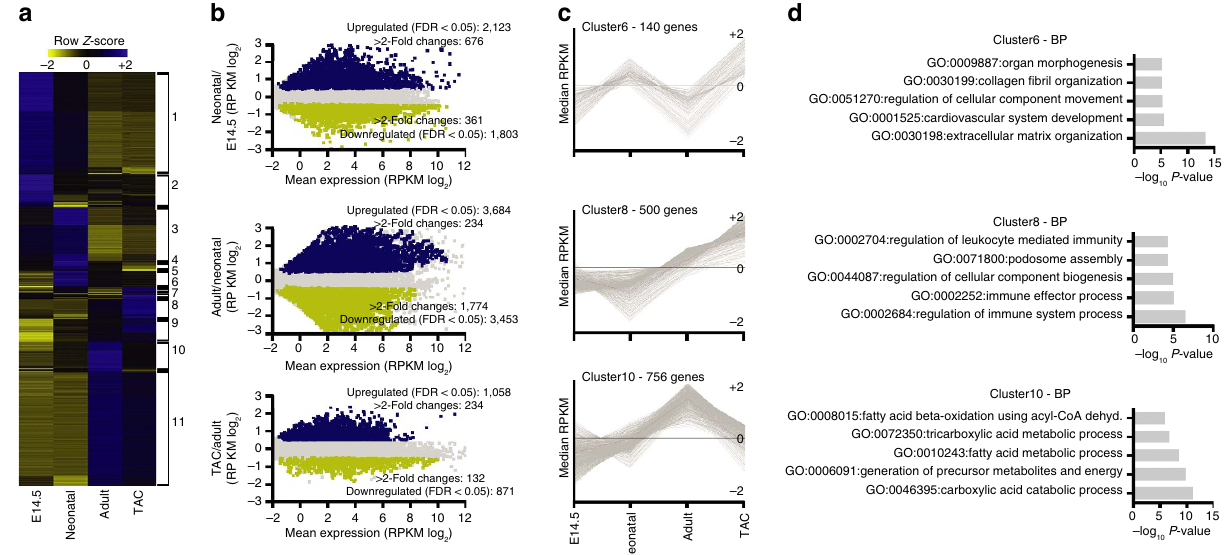
Figure 2 | Transcriptional analysis during development and hypertrophy. ( a ) Hierarchical clustering of the 10,302 transcripts expressed differentially among embryonic, neonatal, normal adult and hypertrophic CMCs (adjusted P -value r 0.05, Benjamini–Hochberg correction for multiple-testing). SOTA cluster numbers are indicated to the right. ( b ) Comparison of gene expression in the developmental and pathological transitions by RNA-seq analysis. Shown are summary dot plots, with blue dots representing upregulated genes and yellow dots representing downregulated genes ( n ¼ 2 samples each; adjusted q -value r 0.05). ( c ) Examples of SOTA clustering analysis of the 10,302 differentially expressed genes. ( d ) Enriched GO terms of the relative SOTA cluster. GO analysis was performed with Metascape 1.0 ( P -value r